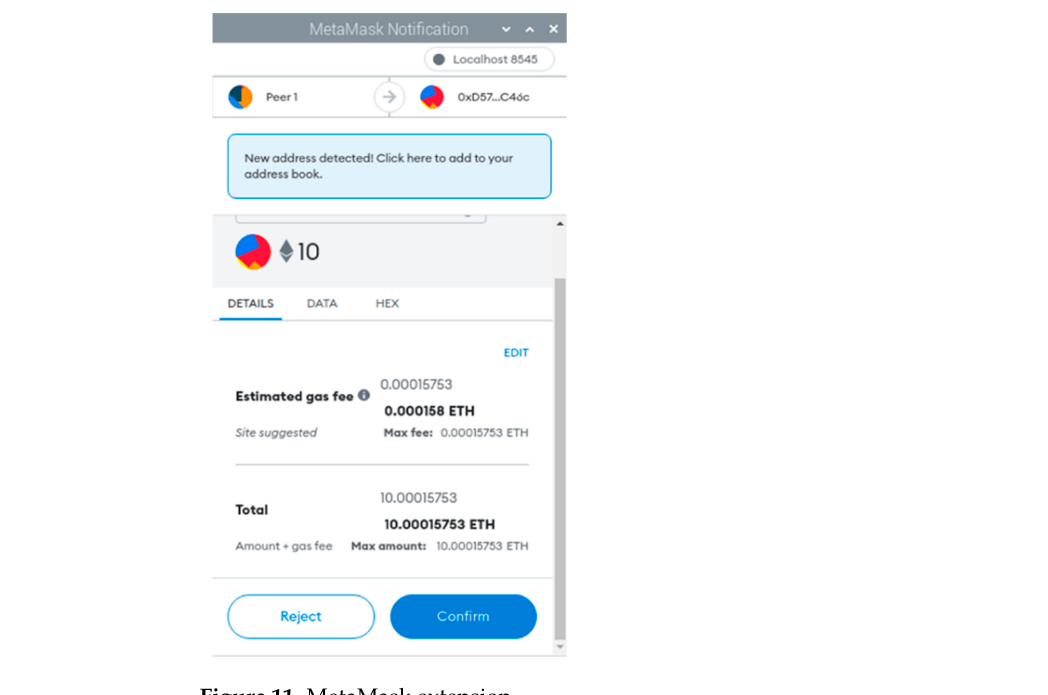
Figure 11. MetaMask extension.